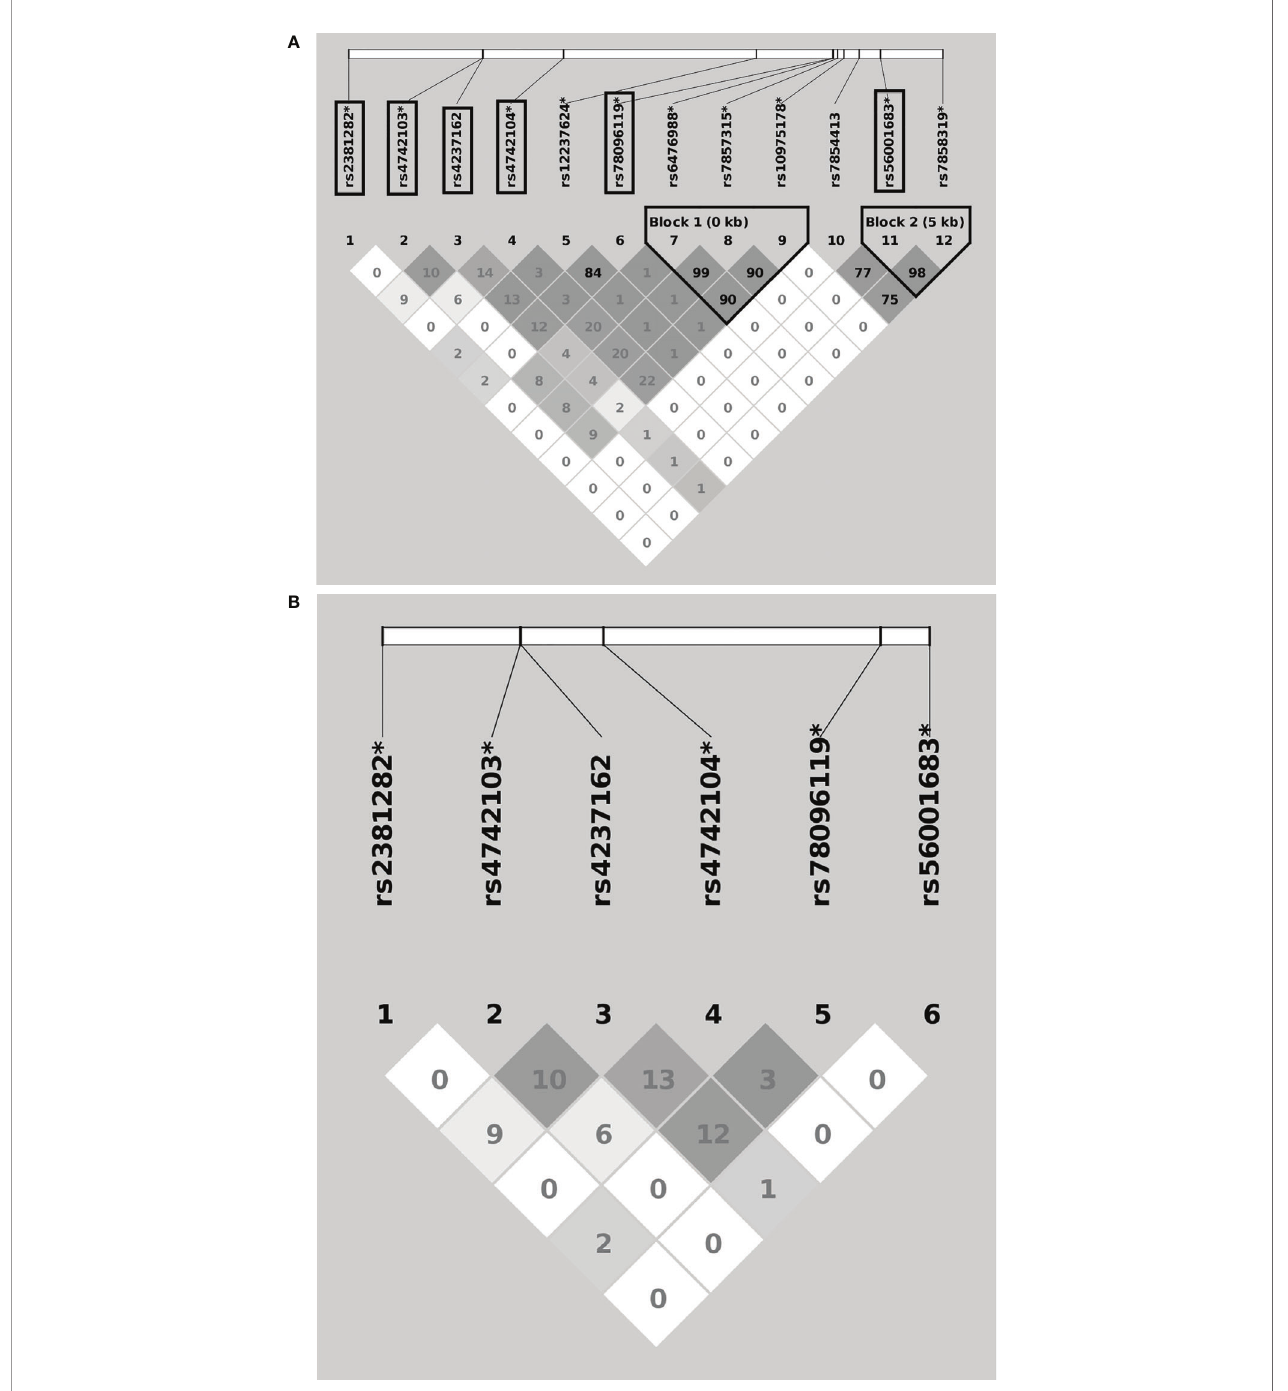
FIGURE 2 | Linkage disequilibrium patterns of the overall 12 (A) and the 6 (B) tagged PDCD1LG2 single nucleotide polymorphisms (SNPs) associated with lung adenocarcinoma risk. The “ * ” indicates imputed SNPs, and the frames indicate the tagged